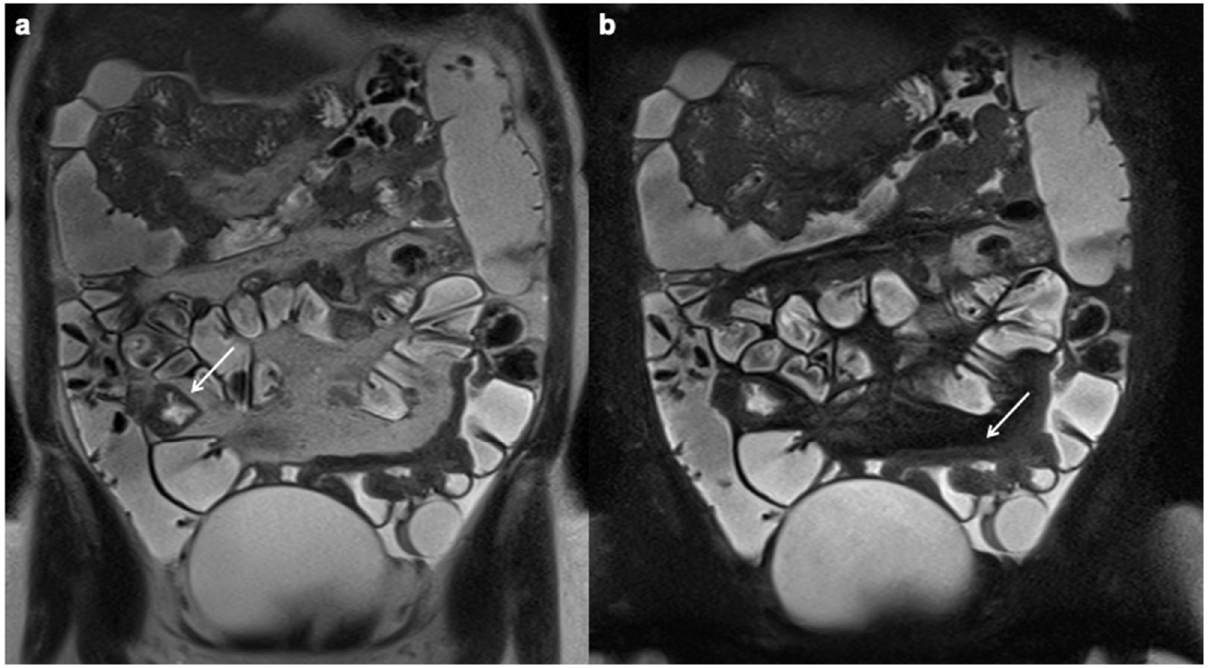
Figure 2. Moderate wall thickening (9 mm). Coronal T2 FSE without FS ( a ) and coronal T2 FSE with FS ( b ) MRE images demonstrate moderate small bowel wall thickening in right flank and pelvic cavity (white arrows), free fluid is associated in the left iliac fossa.